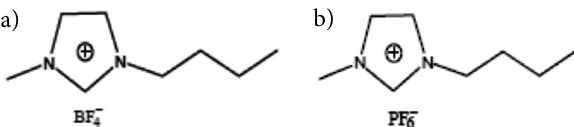
Figure 2. Molecular structure of two ionic liquids: (a) 1-bu- tyl-3-methylimidazolium tetrafluoroborate ([BMIM]BF 4 ); (b) 1-butyl-3-methylimidazolium hexafluorophosphate ([BMIM]PF 6